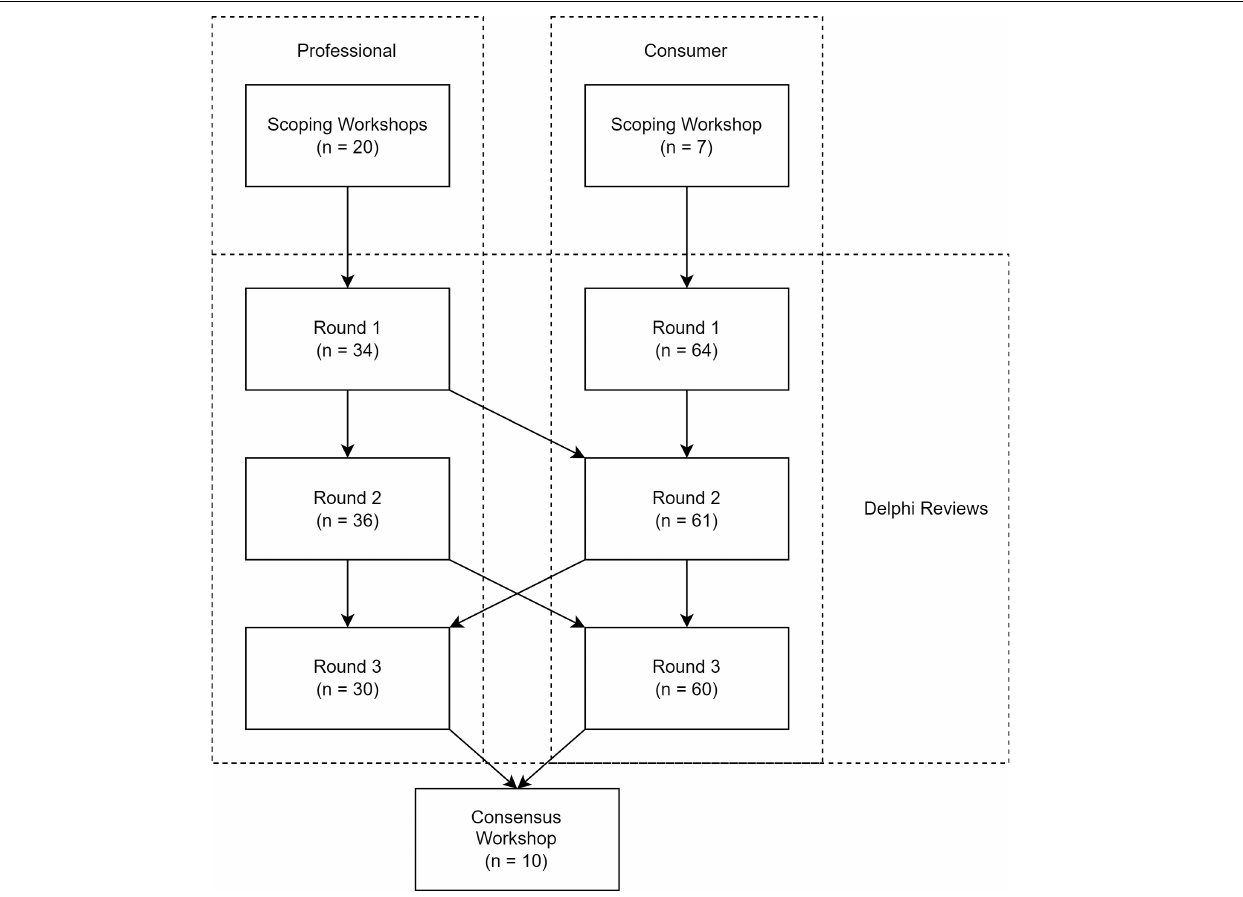
FIGURE 1 | Overall structure of the research study, including the number of participants in each workshop and Delphi round. Information that was used to develop subsequent stages is indicated by